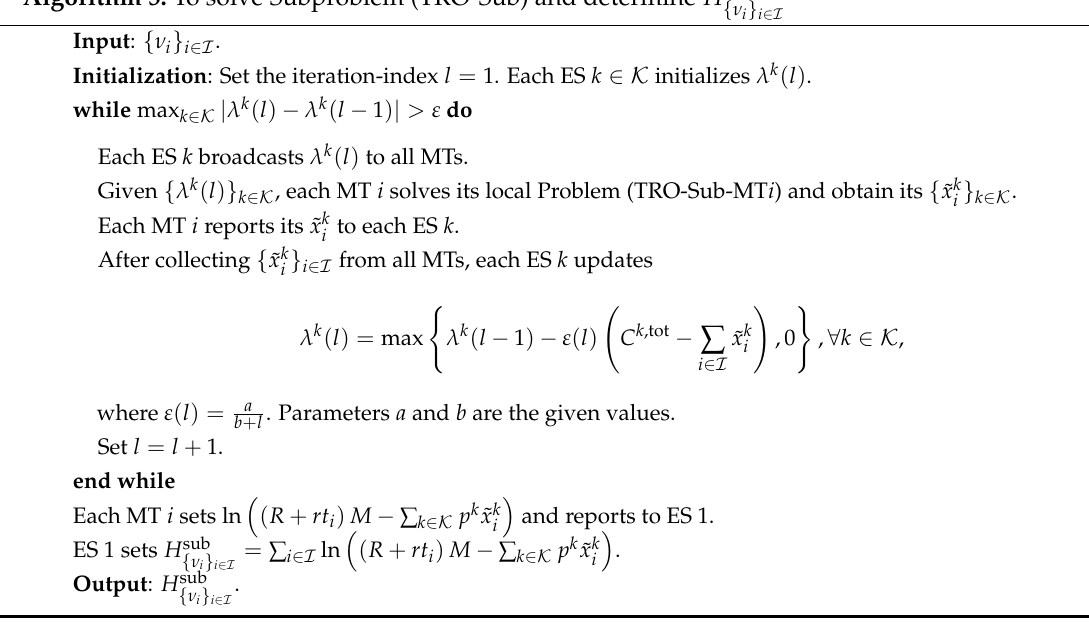
Algorithm 5: To solve Subproblem (TRO-Sub) and determine H sub